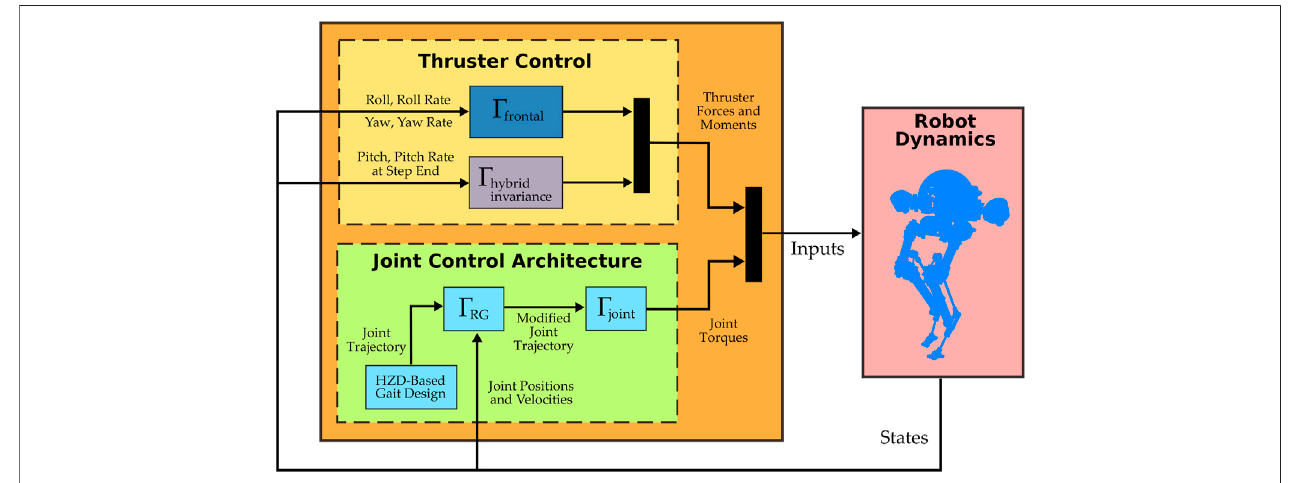
FIGURE 15 | Illustrates the thruster actions during the DS phase. In this plot, the intermediate SS phases are omitted as the thrusters are inactive.